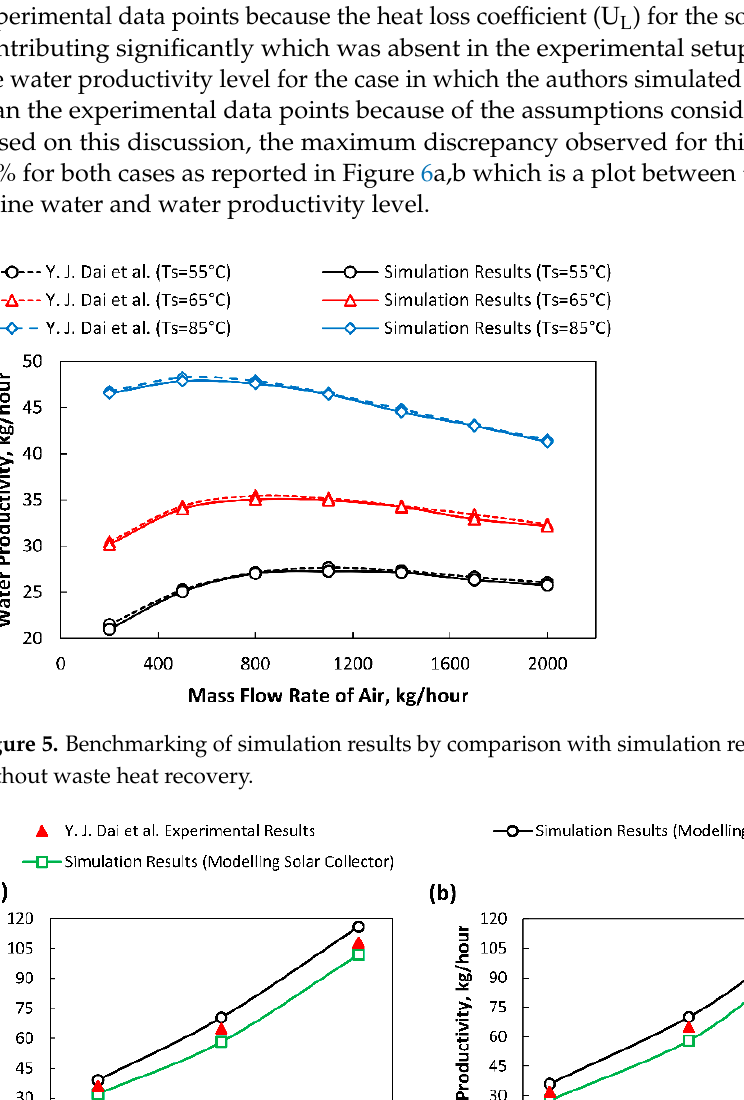
Figure 5. Benchmarking of simulation results by comparison with simulation results of Dai et al. [75] without waste heat recovery.